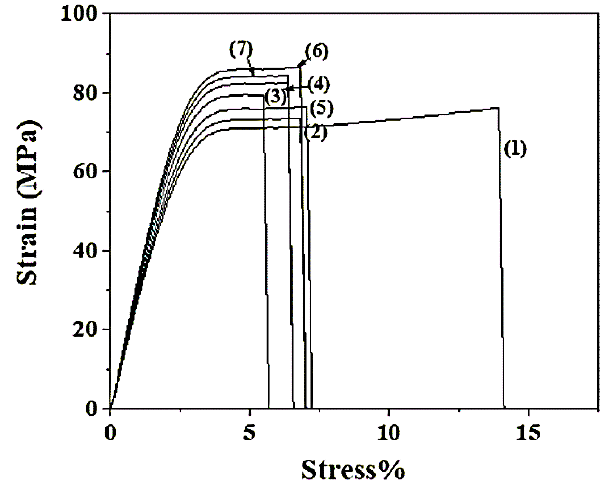
Figure 8. Stress-strain curves of (1) CS/PVOH, (2) CS/PVOH/5HNT, (3) CS/PVOH/10HNT, (4) CS/PVOH/15HNT, (5) CS/PVOH/5TO@HNT, (6) CS/PVOH/10TO@HNT and (7) CS/PVOH/15TO@HNT. Table 1. Calculated values of Young’s (E) Modulus, ultimate tensile strength ( σ uts), and % strain at break ( ε b